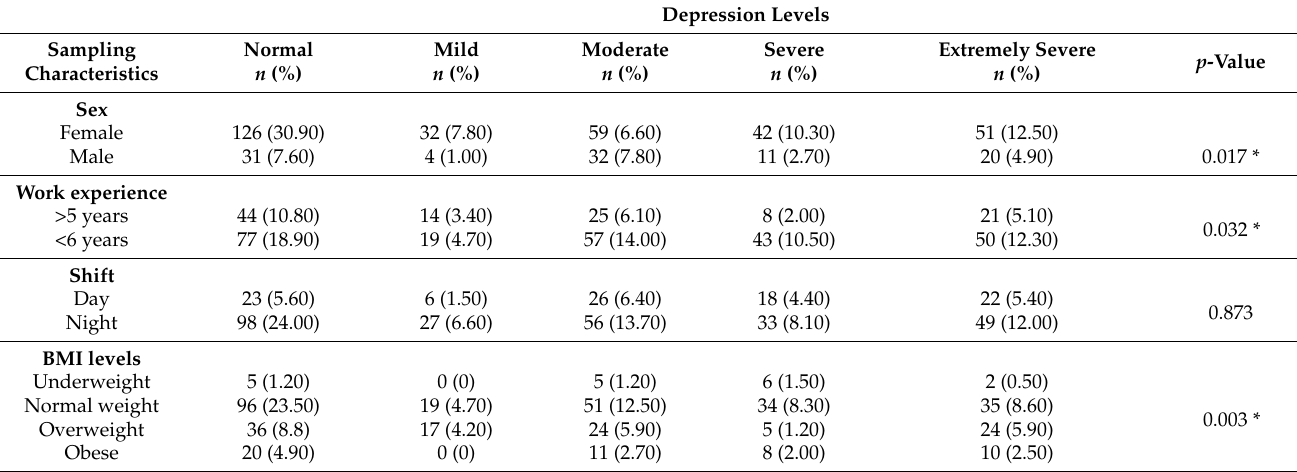
Table 2. Sampling characteristics according to depression